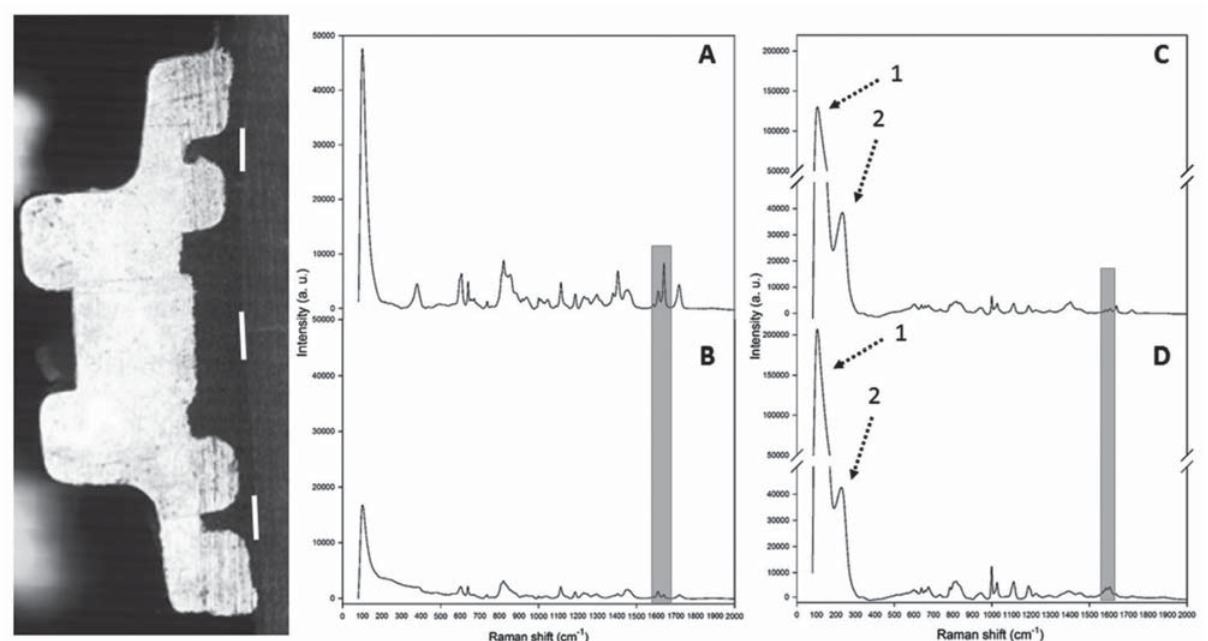
Figure 2- Half of a metal bracket used to analyze degree of conversion (DC) in situ (three lines) before (A) and after (cid:11)(cid:37)(cid:12)(cid:3)(cid:83)(cid:82)(cid:79)(cid:92)(cid:80)(cid:72)(cid:85)(cid:76)(cid:93)(cid:68)(cid:87)(cid:76)(cid:82)(cid:81)(cid:3)(cid:82)(cid:73)(cid:3)(cid:19)(cid:8)(cid:3)(cid:36)(cid:74)(cid:49)(cid:51)(cid:30)(cid:3)(cid:68)(cid:81)(cid:71)(cid:15)(cid:3)(cid:69)(cid:72)(cid:73)(cid:82)(cid:85)(cid:72)(cid:3)(cid:11)(cid:38)(cid:12)(cid:3)(cid:68)(cid:81)(cid:71)(cid:3)(cid:68)(cid:73)(cid:87)(cid:72)(cid:85)(cid:3)(cid:11)(cid:39)(cid:12)(cid:3)(cid:83)(cid:82)(cid:79)(cid:92)(cid:80)(cid:72)(cid:85)(cid:76)(cid:93)(cid:68)(cid:87)(cid:76)(cid:82)(cid:81)(cid:3)(cid:82)(cid:73)(cid:3)(cid:19)(cid:17)(cid:22)(cid:22)(cid:8)(cid:3)(cid:36)(cid:74)(cid:49)(cid:51)(cid:3)(cid:62)(cid:75)(cid:76)(cid:74)(cid:75)(cid:79)(cid:76)(cid:74)(cid:75)(cid:87)(cid:3)(cid:82)(cid:73)(cid:3)(cid:87)(cid:75)(cid:72)(cid:3)(cid:83)(cid:72)(cid:68)(cid:78)(cid:86)(cid:3) (cid:70)(cid:82)(cid:85)(cid:85)(cid:72)(cid:86)(cid:83)(cid:82)(cid:81)(cid:71)(cid:76)(cid:81)(cid:74)(cid:3)(cid:87)(cid:82)(cid:3)(cid:68)(cid:85)(cid:82)(cid:80)(cid:68)(cid:87)(cid:76)(cid:70)(cid:3)(cid:11)(cid:20)(cid:25)(cid:20)(cid:19)(cid:3)(cid:70)(cid:80)(cid:16)(cid:20)(cid:12)(cid:3)(cid:68)(cid:81)(cid:71)(cid:3)(cid:68)(cid:79)(cid:76)(cid:83)(cid:75)(cid:68)(cid:87)(cid:76)(cid:70)(cid:3)(cid:11)(cid:20)(cid:25)(cid:23)(cid:19)(cid:3)(cid:70)(cid:80)(cid:16)(cid:20)(cid:12)(cid:3)(cid:71)(cid:82)(cid:88)(cid:69)(cid:79)(cid:72)(cid:3)(cid:69)(cid:82)(cid:81)(cid:71)(cid:86)(cid:64)(cid:17)(cid:3)(cid:36)(cid:85)(cid:85)(cid:82)(cid:90)(cid:86)(cid:3)(cid:86)(cid:75)(cid:82)(cid:90)(cid:3)(cid:87)(cid:75)(cid:72)(cid:3)(cid:70)(cid:75)(cid:68)(cid:85)(cid:68)(cid:70)(cid:87)(cid:72)(cid:85)(cid:76)(cid:86)(cid:87)(cid:76)(cid:70)(cid:3)(cid:53)(cid:68)(cid:80)(cid:68)(cid:81)(cid:3) (cid:83)(cid:72)(cid:68)(cid:78)(cid:86)(cid:3)(cid:82)(cid:73)(cid:3)(cid:86)(cid:76)(cid:79)(cid:89)(cid:72)(cid:85)(cid:3)(cid:70)(cid:82)(cid:80)(cid:83)(cid:82)(cid:88)(cid:81)(cid:71)(cid:86)(cid:29)(cid:3)(cid:11)(cid:20)(cid:12)(cid:3)(cid:43)(cid:76)(cid:74)(cid:75)(cid:72)(cid:85)(cid:3)(cid:76)(cid:81)(cid:87)(cid:72)(cid:81)(cid:86)(cid:76)(cid:87)(cid:92)(cid:3)(cid:70)(cid:82)(cid:80)(cid:83)(cid:68)(cid:85)(cid:72)(cid:71)(cid:3)(cid:90)(cid:76)(cid:87)(cid:75)(cid:3)(cid:19)(cid:8)(cid:3)(cid:36)(cid:74)(cid:49)(cid:51)(cid:3)(cid:76)(cid:86)(cid:3)(cid:71)(cid:88)(cid:72)(cid:3)(cid:87)(cid:82)(cid:3)(cid:87)(cid:75)(cid:72)(cid:3)(cid:36)(cid:74)(cid:3)(cid:79)(cid:68)(cid:87)(cid:87)(cid:76)(cid:70)(cid:72)(cid:3)(cid:89)(cid:76)(cid:69)(cid:85)(cid:68)(cid:87)(cid:76)(cid:82)(cid:81)(cid:68)(cid:79)(cid:3)(cid:80)(cid:82)(cid:71)(cid:72)(cid:3)(cid:11)(cid:20)(cid:20)(cid:23)(cid:15)(cid:3) 140, 146, and 158 cm-1) and (2) Ag-O stretching/bending modes from AgO